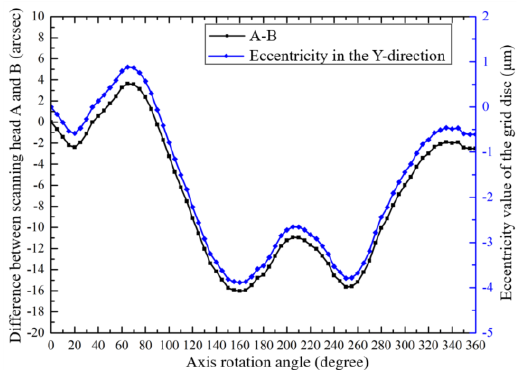
Figure 7. The di ff erence between the two scanning heads’ indications and assembly eccentricity of the grid disc.